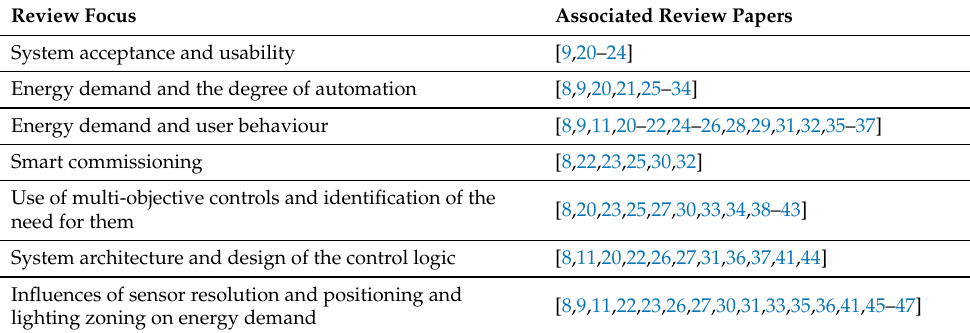
Table 4. Identification and classification of the filtered review articles.